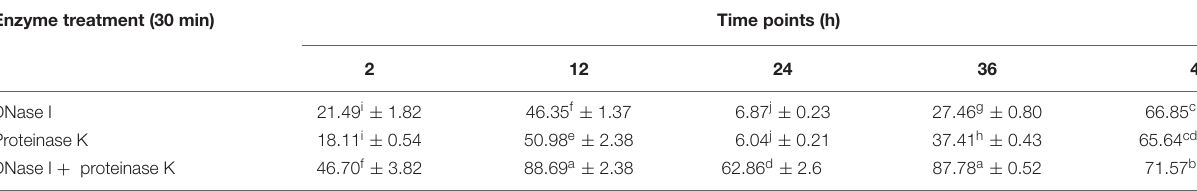
TABLE 3 | Clearance of biofilm by different enzymes (%).